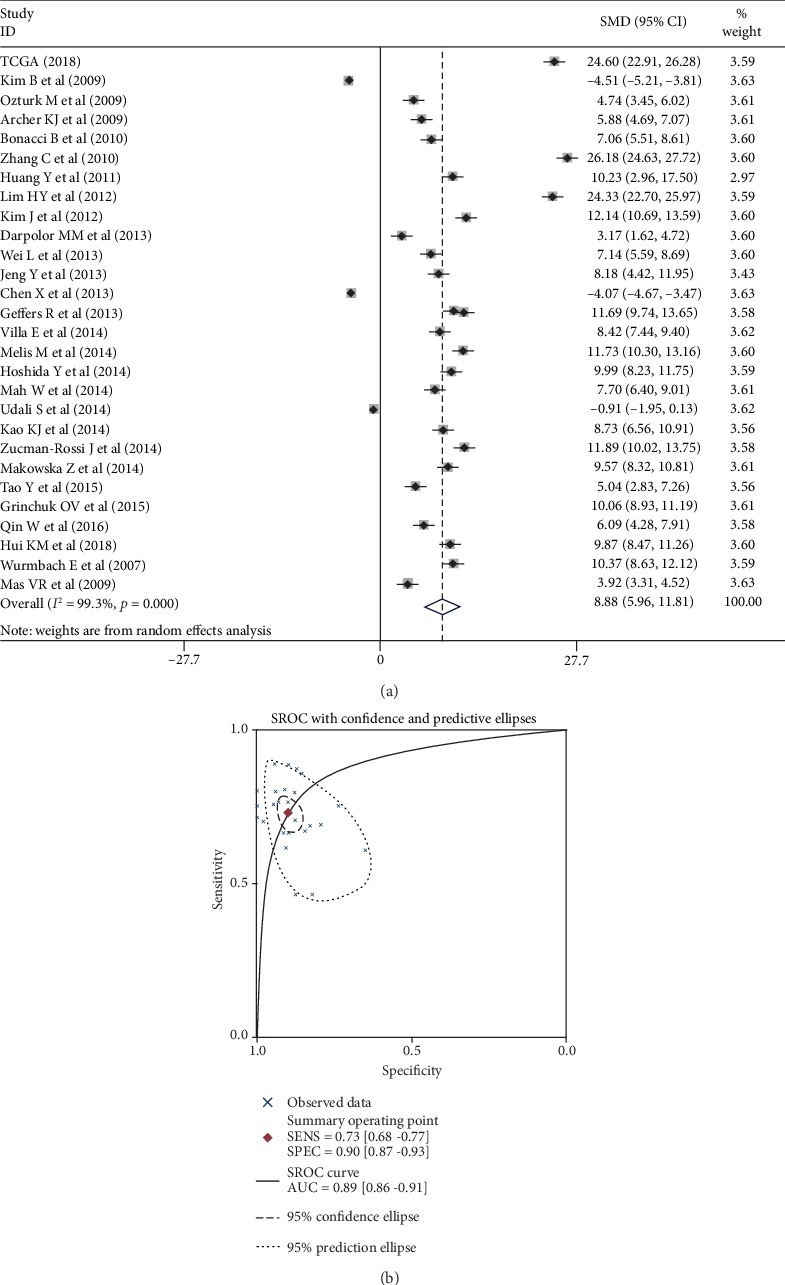
A meta-analysis of ATAD2 differential expression in HCC vs. nontumor tissues based on 28 datasets. (a) Forest plot on ATAD2 expression between HCC and nontumor tissues. (b) SROC curves for ATAD2 differential expression in HCC patients from nontumor tissues.